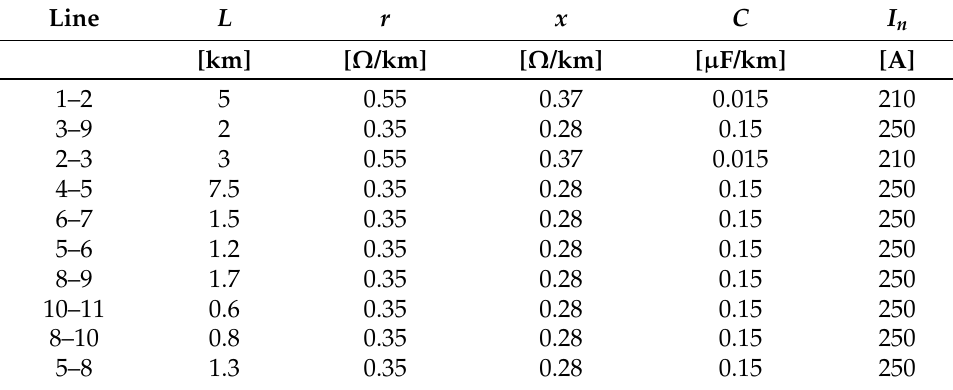
Table 10. Data lines.